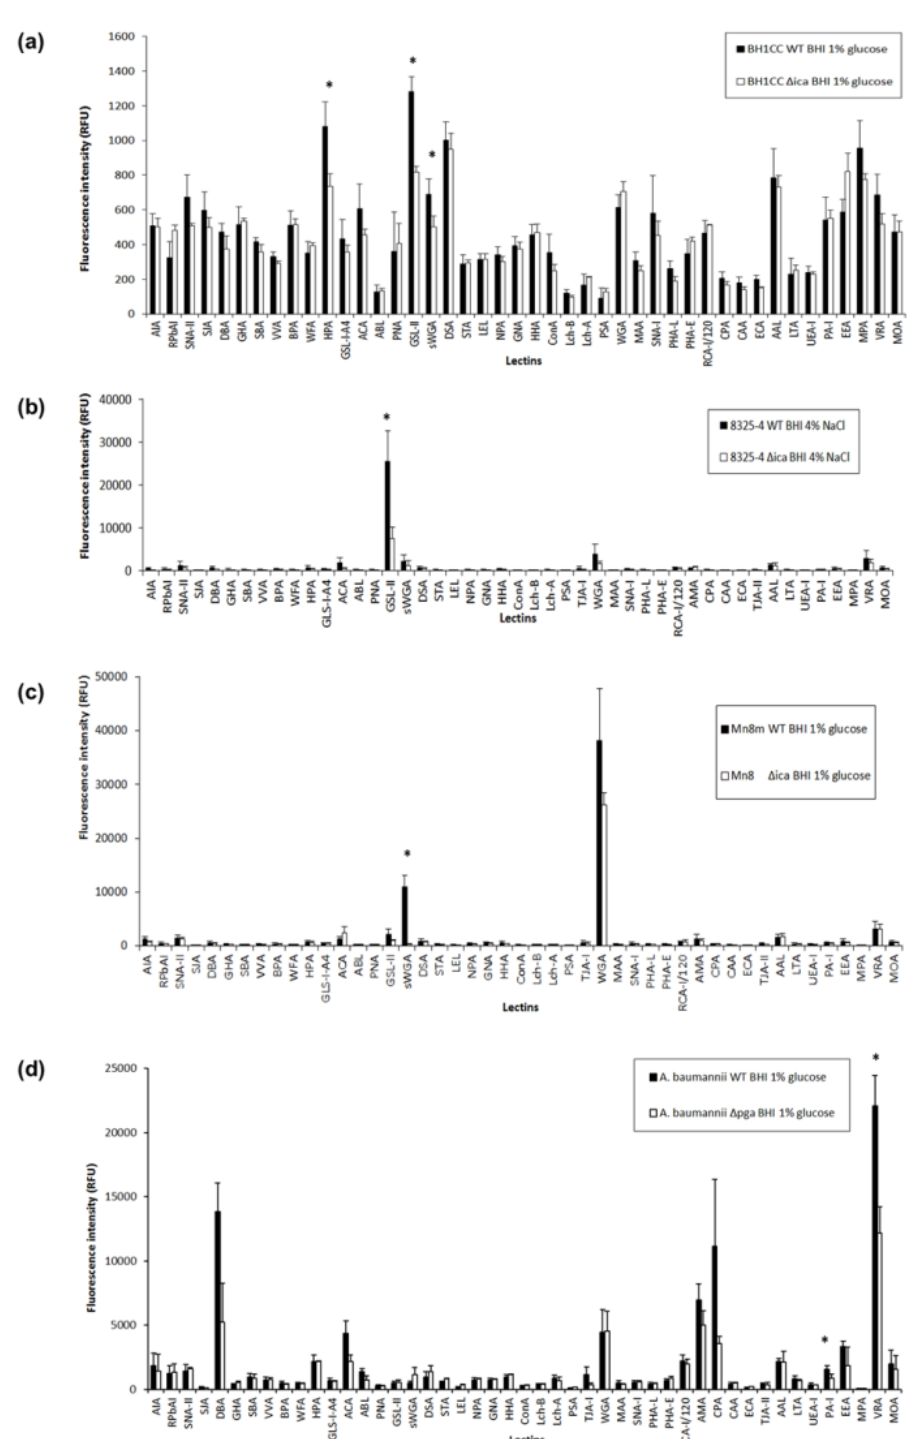
Figure 3. Surface glycosylation profiles of WT bacterial strains grown in BHI media supplemented with glucose or NaCl. Bar charts represent binding intensities of bacteria to lectins on the lectin microarray. ( a ) S. aureus BH1CC WT and ∆ ica mutant bacterial strains grown in BHI media with 1% glucose, ( b ) S. aureus 8325-4 WT and ∆ ica mutant bacterial strains grown in BHI media with 4% NaCl, ( c ) S. aureus Mn8m and Mn8 ∆ ica mutant bacterial strains grown in BHI media with 1% glucose, and ( d ) A. baumannii WT and ∆ pga grown in BHI media with 1% glucose. Bars represent the mean of three experiments with error bars of +/ − 1 SD of the mean. * represents significant di ff erence ( p ≤ 0.05, calculated by Student’s t-test, two tailed) in binding between WT and ∆ pga / ∆ ica .